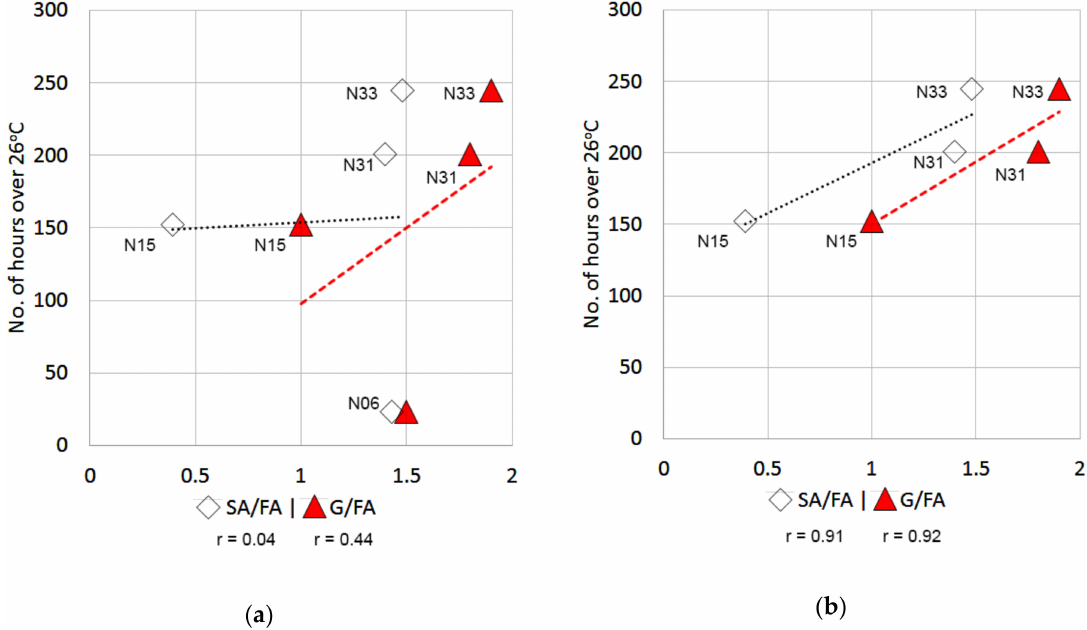
Figure 9. High temperature hours vs. surface area to floor area ratio (SA / FA) and glazing to floor area ratio (GA / FA): ( a ) Flats N31, N33, N15, N06; ( b ) Flats N31, N33,